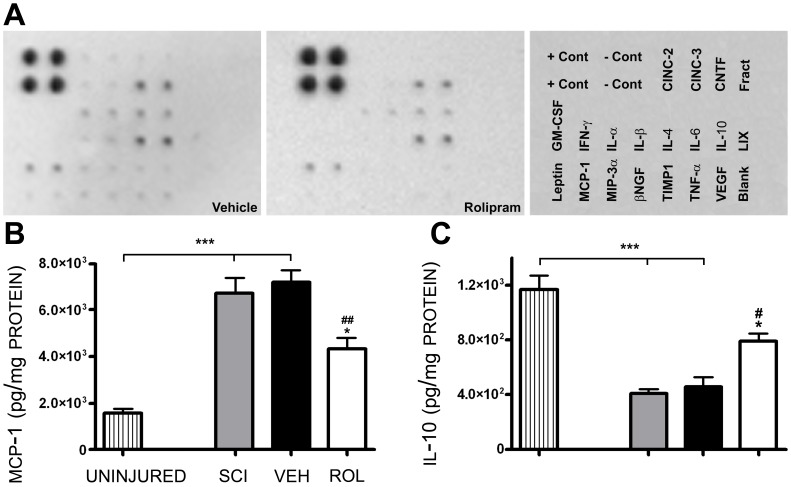
Acute Rolipram treatment reduces monocyte chemoattractant protein levels while delayed administration increases interleukin-10 levels.Spinal cord encompassing the injury epicenter or the uninjured T8 segment was harvested and analyzed for concentrations of cytokines by protein array (See Table 2) or used to measure MCP-1 and IL-10 using specific ELISAs. A. Representative images from cytokine protein arrays of SCI with vehicle and SCI with Rolipram (at 1 h post-SCI) animals 2 h post-injury. The far right panel shows the arrangement of cytokine antibodies and positive/negative controls on the membrane. B. ELISA shows a significant increase in MCP-1 at 2 h post-SCI compared to uninjured controls (lined bar) that was attenuated by Rolipram (white bar), but not vehicle, when given at 1 h. C. IL-10 protein levels were significantly reduced at 25 h post-SCI compared to uninjured controls (lined bar). Rolipram (white bar), but not vehicle, partially prevented the SCI-induced decrease in IL-10 when given at 24 h. Statistical significance indicated at *p<0.05 compared to injury only controls (gray bars) and #p<0.05 or ##p<0.01 compared to vehicle controls (black bars). Error bars are expressed as SEMs.